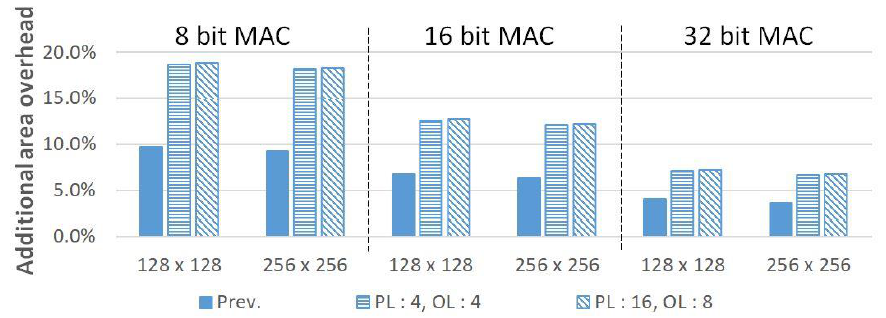
Figure 13. Hardware overhead comparison under the same number of redundancies condition.